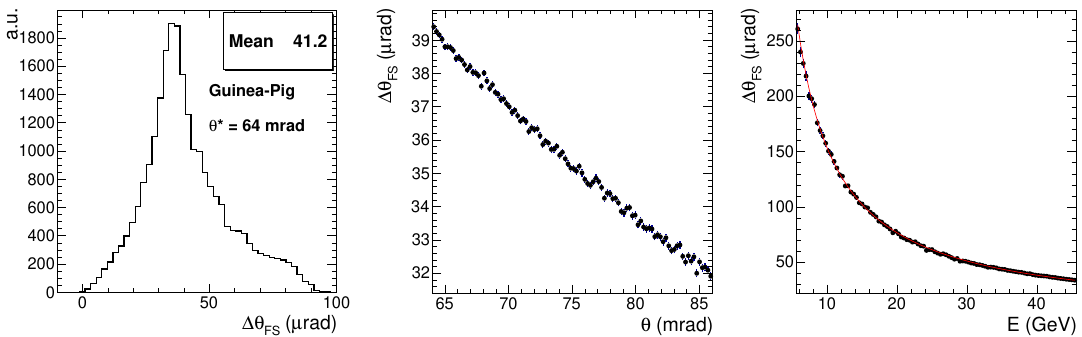
Figure 5 . Left: Distribution of the angular focusing (cid:1) (cid:18) for electrons with E = 45 : 6 GeV and FS emitted at a (cid:12)xed angle (cid:18) (cid:3) = 64 mrad with respect to the electron beam direction. Middle and right: (cid:1) (cid:18) as a function of (middle) the polar angle and (left) the energy of the outcoming lepton FS in Bhabha events. The events were generated with the BHWIDE program, in the angular range 64 mrad < (cid:18) (cid:3) < 86 mrad. A (cid:12)t to (cid:1) (cid:18) / 1 =E is overlaid on the right plot. FS